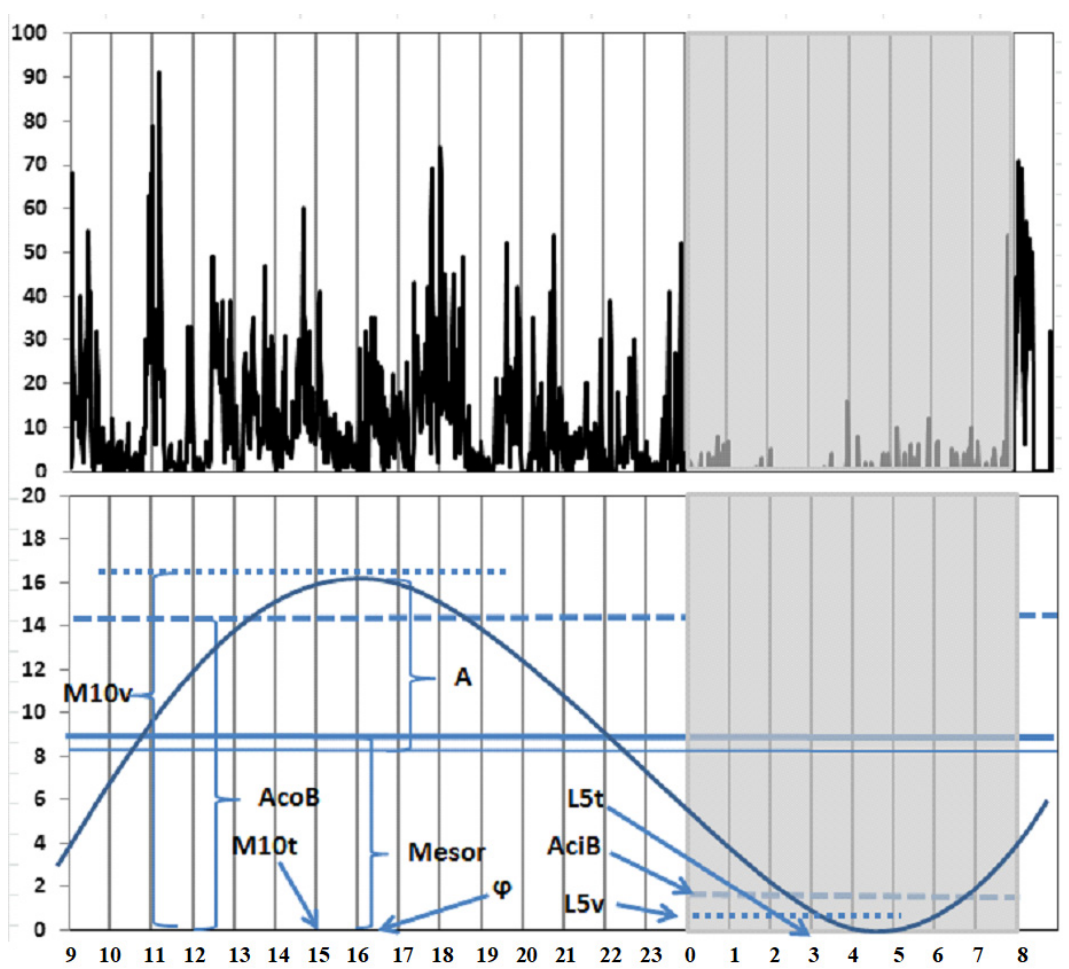
Figure 2. Example of 24 h rest–activity rhythm ( upper panel ) and 24 h rest–activity rhythm char- acteristics ( lower panel ). The abscissa axis represents the local time in hours, the ordinate axis rep- resents the level of motor activity in arbitrary units, and the measurement step is 1 min. Rectangles highlighted in color: time in bed; MESOR: Medline estimating statistics of rhythm; A: amplitude; φ : acrophase; M10(t): most active 10 h period (mid-phase of M10); L5(t): least active 5 h period (mid-phase of L5); AcoB: motor activity outside of bed; AciB: motor activity in bed at night.